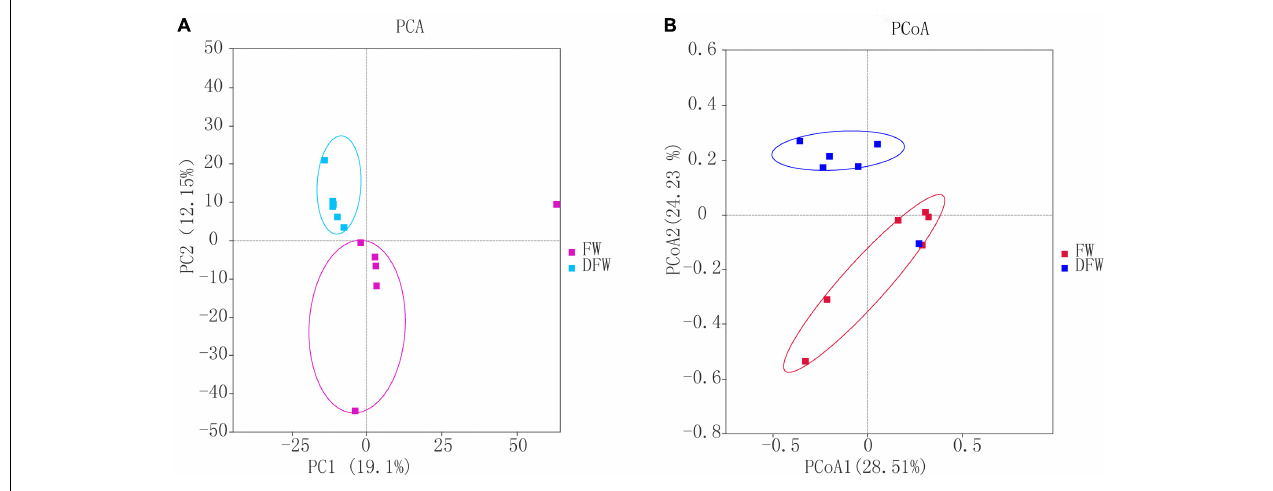
FIGURE 1 | PCA (A) and PCoA (B)